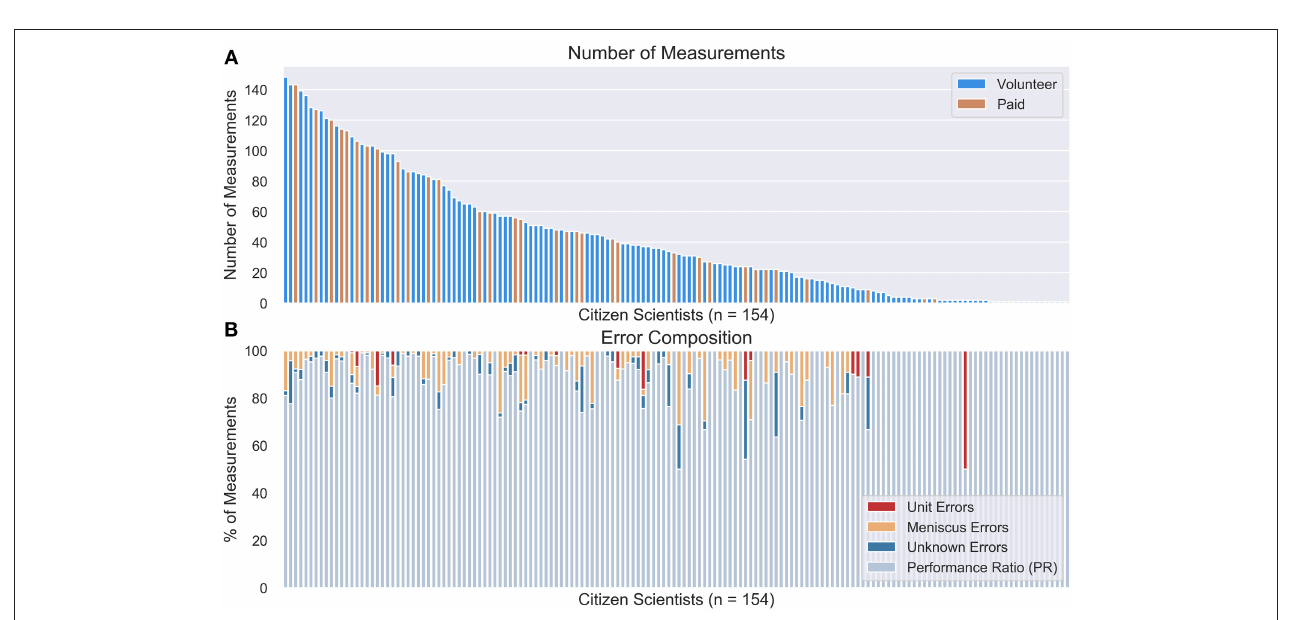
FIGURE 9 | Scatter plot of corrected records ( n = 592) with original (i.e., raw) precipitation entries on the horizontal axis and edited (i.e., after quality control) values on the vertical axis. Data is shown for three different scales: (A) 0–10mm, (B) 0–50mm, and (C) 0–200mm. Meniscus error range ( n = 346) is shown as light blue area, while Unit error range ( n = 50) is shown as light red sector. Points outside of the light blue and light red areas are unknown errors ( n = 196).